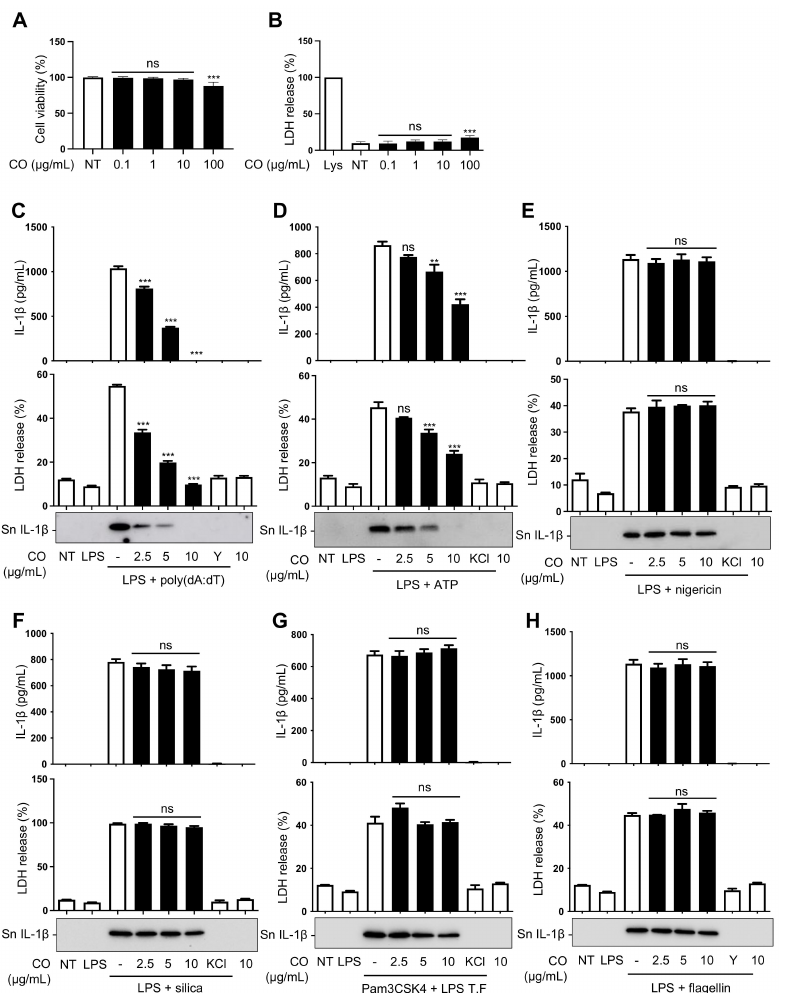
Figure 2. CO inhibits the release of IL-1 β and the cell death of LPS-primed BMDMs induced by intracellular poly(dA:dT). ( A , B ) Cell viability of BMDMs treated with the indicated concentrations of CO and measured by MTT and LDH assays. Data represent the means ± SDs of three independent experiments performed in triplicate; ** p < 0.01, *** p < 0.001, ns (non-significant) compared with the non-treated group. ( C – F , H ) LPS (100 ng/mL)-primed BMDMs were pre-treated with CO or 50 µ M YVAD (Y) or KCl (150 mM) for 30 min and treated with ( C ) poly(dA:dT) transfection (1 µ g/mL) for 2 h, ( D ) ATP (5 mM) for 1 h, ( E ) nigericin (10 µ M) for 1 h, ( F ) silica (150 µ g/mL) for 3 h, and ( H ) flagellin (1 µ g/mL) transfection for 3 h. ( G ) Pam3CSK4 (300 ng/mL)-primed BMDMs were pre-treated with CO or KCl, as described above, then transfected with LPS (50 µ g/mL) for 3 h. ( C – H ) Levels of IL-1 β in the culture supernatants were assessed by immunoblot or ELISA assay. Occurrence of pyroptotic cell death was assessed by LDH assay. Data represent the means ± SEMs of three independent experiments performed in triplicate; ** p < 0.01, *** p < 0.001, ns (non-significant) compared with the LPS-primed BMDMs treated with the respective